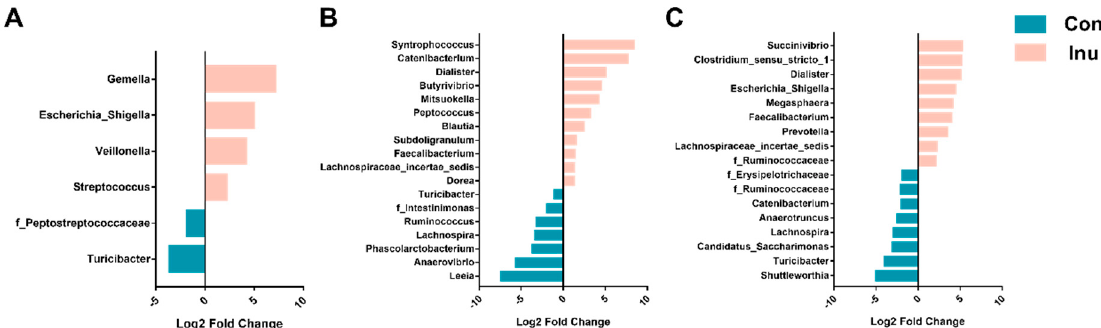
Figure 3. Differentially abundant ( p < 0.05) genera from the ileum ( A ), cecum ( B ), and colon ( C ) in growing pigs fed a diet with or without a 5% inulin supplement, as determined by DeSeq2. OTUs clustered at 97% similarity were combined by taxonomic classification at the genus level. The results shown are log2 fold change between the CON (control; blue) and INU (inulin; red)-fed groups; note that the x-axis scale is different for each panel. Positive log-fold changes indicate that a genus is enriched in the INU group, while negative log-fold changes indicate that a genus is enriched in the CON group. Con, control; Inu, inulin.